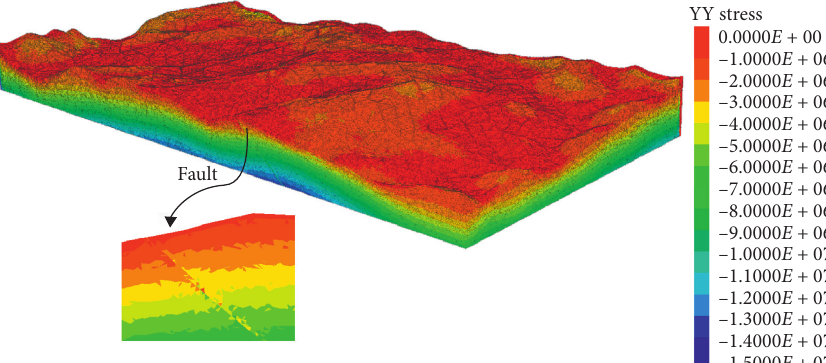
Figure 7: Horizontal in situ stress component in Y direction (N-S direction).